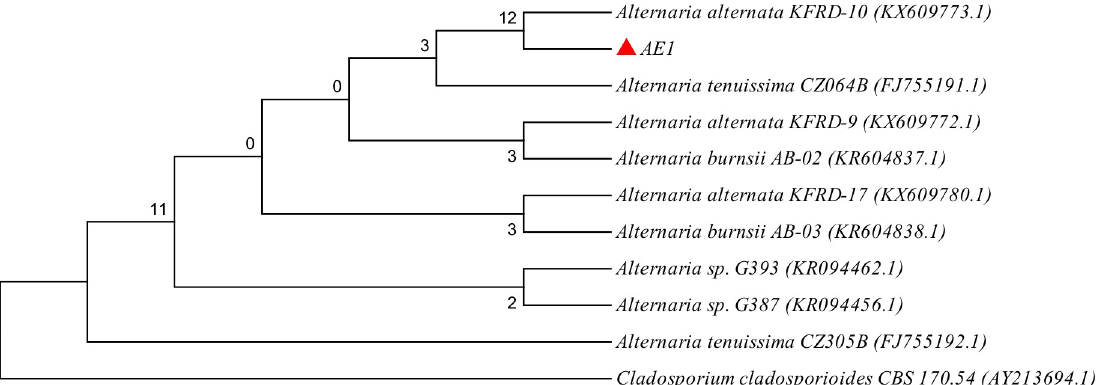
Fig 2. Neighbor joining phylogenetic tree on the basis of 28S rDNA (D1/D2 region) sequence of AE1.